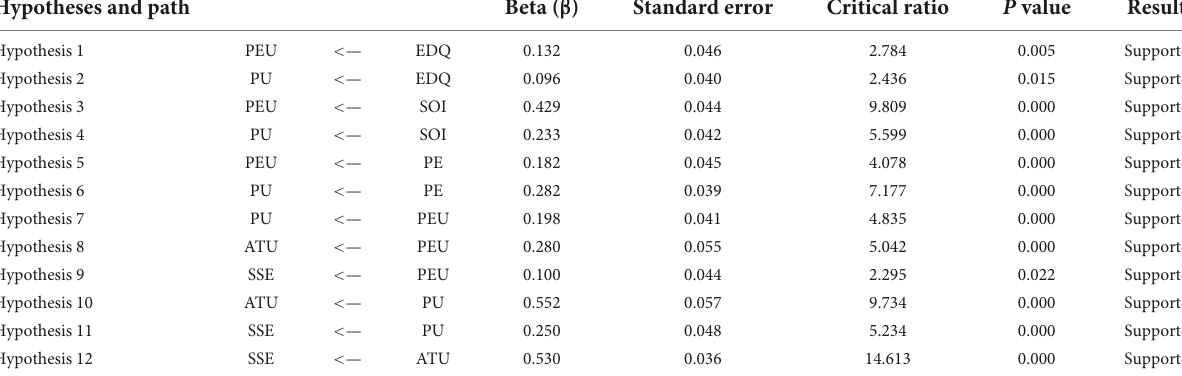
TABLE 6 Measuring educational quality.